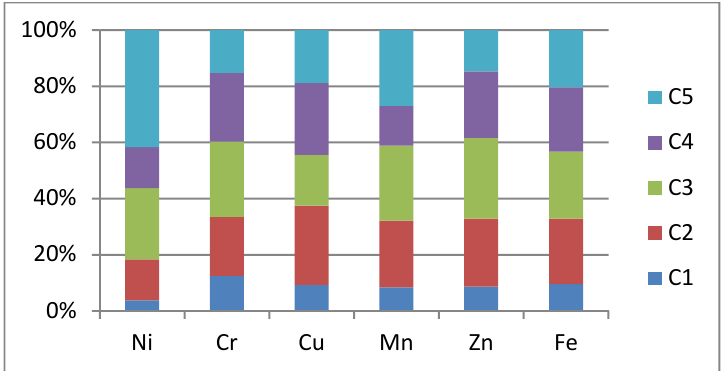
Figure 4. The comparative distribution of metals in the hazelnut samples.